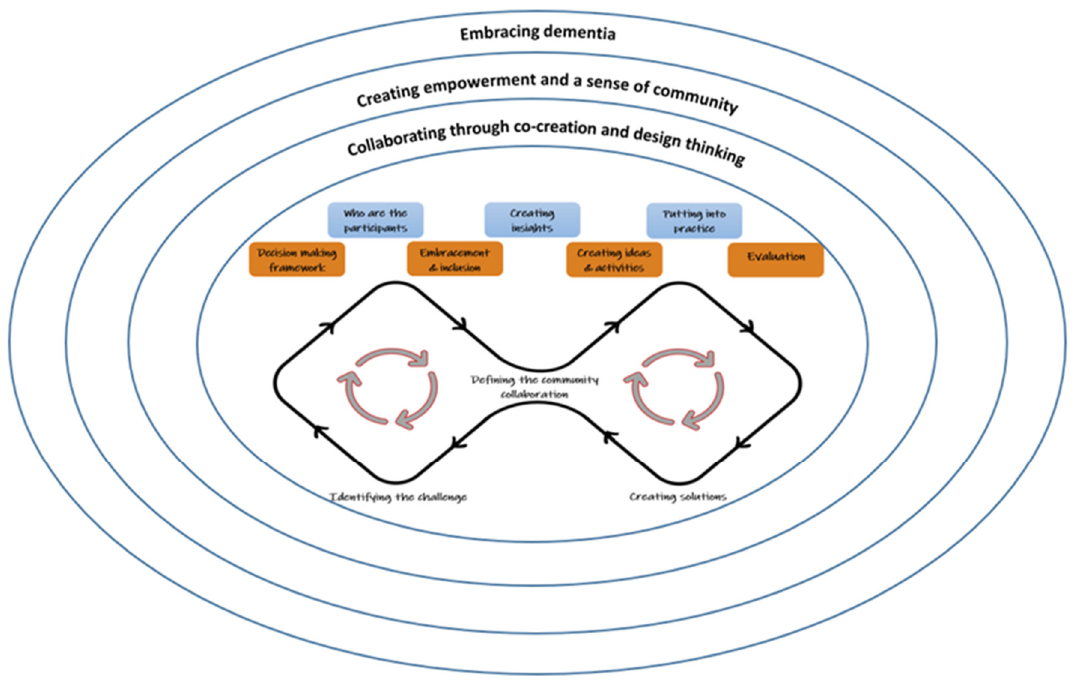
Figure 2. The Community Collaboration Conceptual Framework.